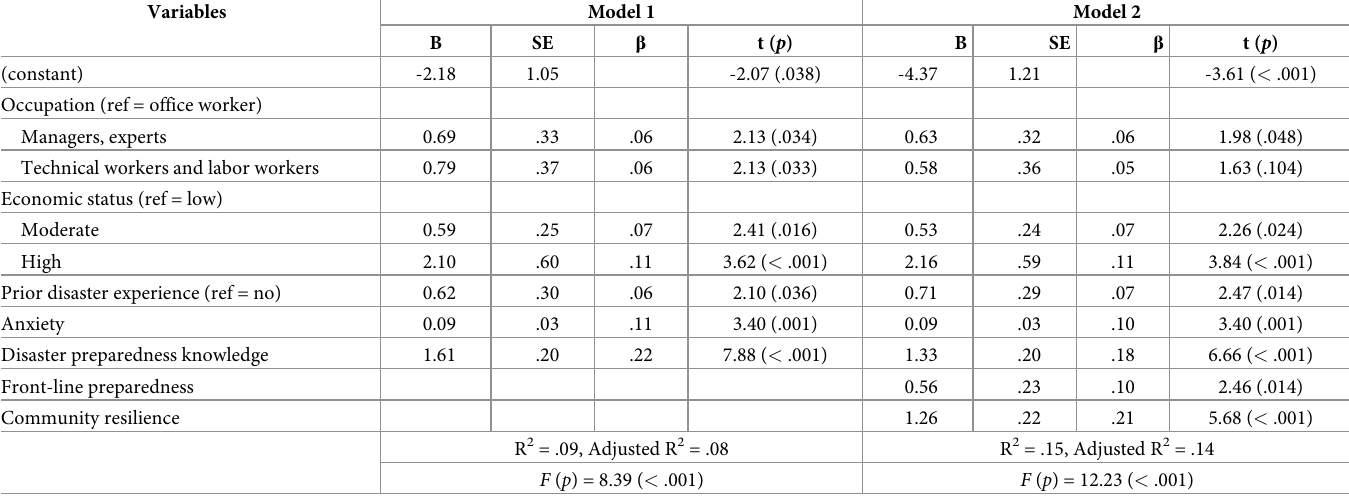
Table 3. Factors influencing household disaster preparedness ( N =